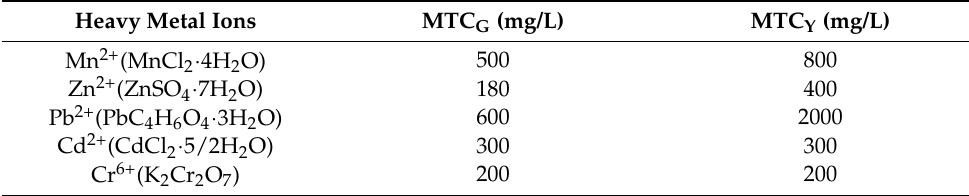
Table 3. Tolerance of strain LBA119 to single heavy